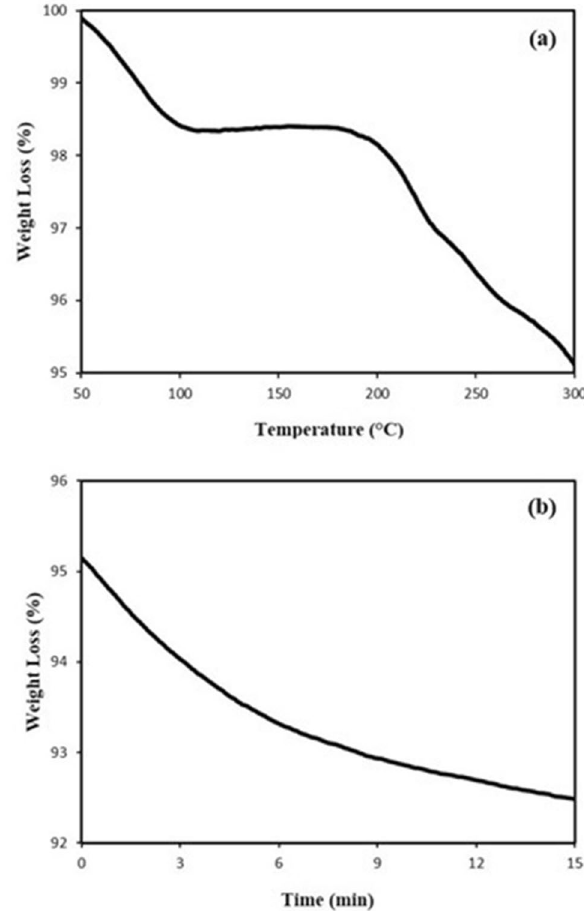
Fig. 5 TGA diagram of PMMA (as received) a up to 300 ◦ C , b after ◦ 15-min holding at 300